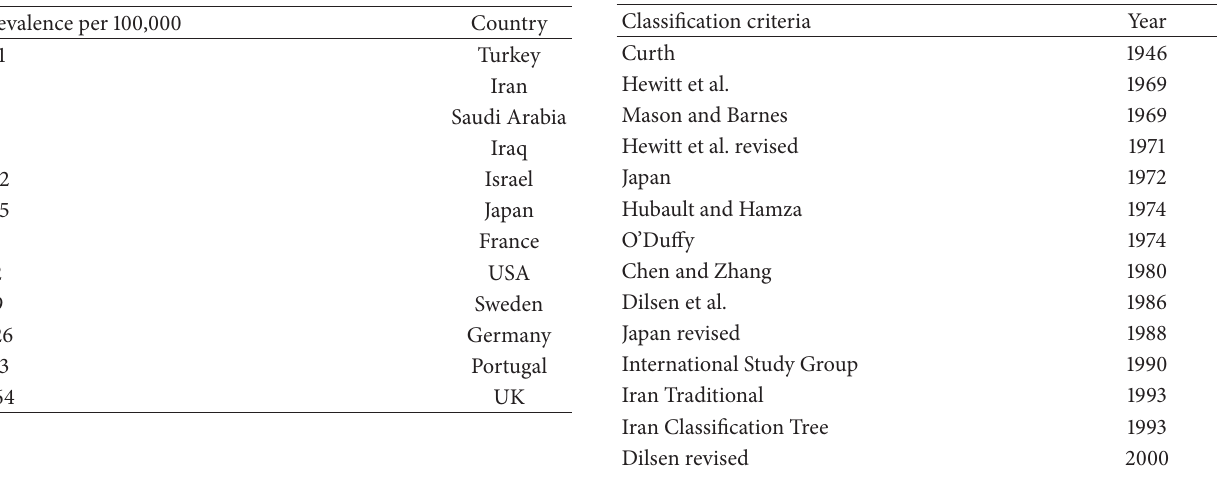
Table 1: Worldwide prevalence of Behcet’s Disease [6]. Table 2: Classification criteria for Behcet’s Disease